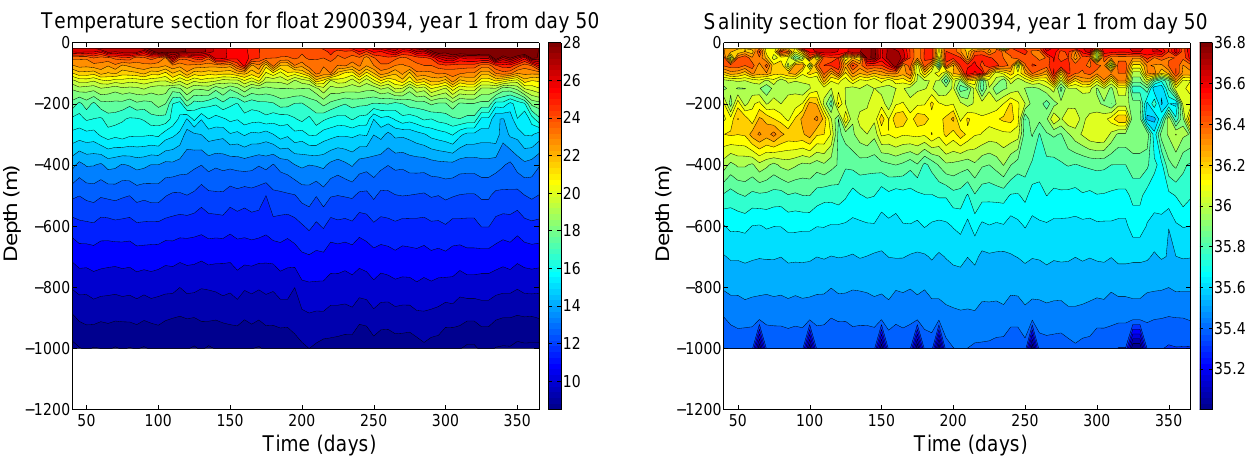
Fig. 23. Vertical sections of temperature (in ◦ C, left) and of salinity (right) along float 2900394 trajectory for year 1 from day 50.